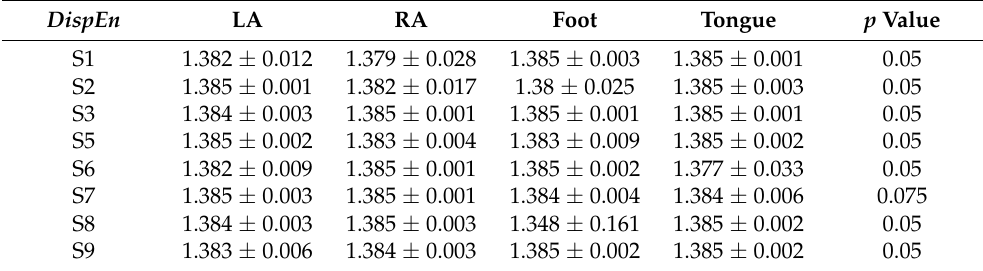
Table 6. The average values (mean ± SD) of DispEn to estimate the MI-BCI performance from four classes (left hand, right hand, feet, and tongue) of eight subjects individually.